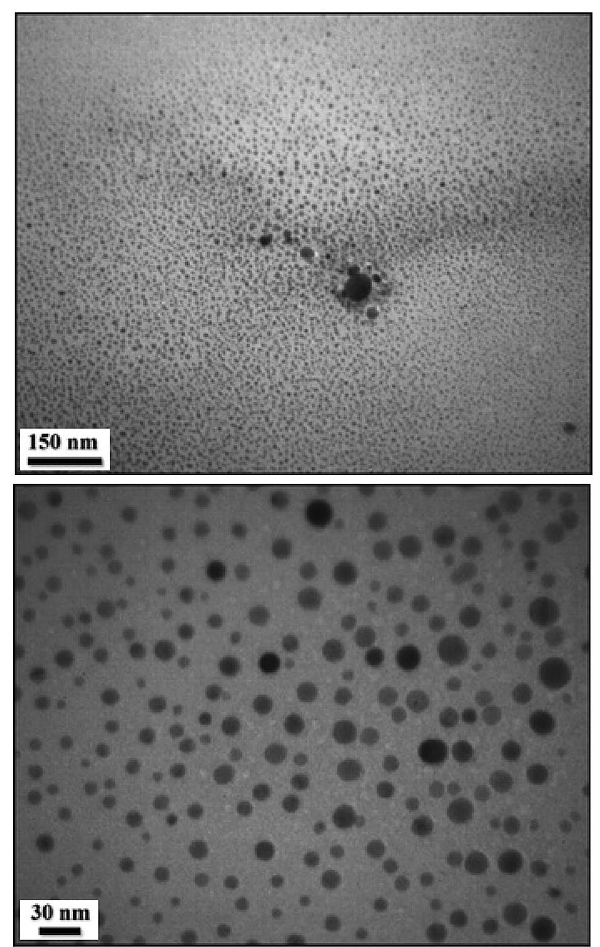
Figure 7. TEM images of biogenic CuO